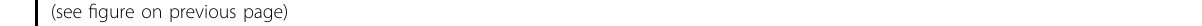
Fig. 6 PROM2 augments gemcitabine chemoresistance by binding to Akt. a Immunoprecipitation assays showing PROM2 interacts with Akt. b PROM2 binds to Akt endogenously. c Protein expressions of p-BAD and p-Caspase-9 are inhibited when silencing Akt. d IC 50 value of gemcitabine in the indicated cells after Akt knockdown (* P <0.05). e Luminescence signaling of tumors formed by AsPC-1/PROM2 cells after treatment with control or Akt shRNA (* P <0.05). f Tumor weight of tumors formed by AsPC-1/PROM2 cells after treatment with control or Akt shRNA (* P <0.05). g Representative images of the immunostaining in tumors tissues (* P <0.05). h Far-western blotting indicated that Flag-PROM2 interacted with recombinant GST-AKT directly. i Schematic illustration of full length PROM2 and truncations (left) and co-IP assays revealed AKT bound with FL, F1, and F4 fragments, but not with F2 and F3 fragments (right). j Immunoprecipitation assays illustrating the inhibitory effect of PROM2-F4 on the PROM2-AKT interaction. k Quanti fi cation of Annexin-V apoptotic